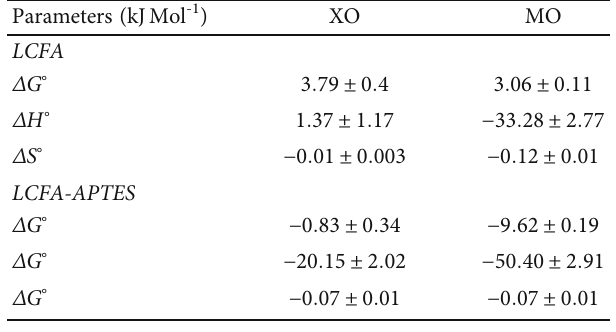
the kinetic e ff ect, pseudo fi rst-order and pseudosecond- Table 6: Thermodynamic parameters for the adsorption of MO